Question: Which visualization type does this figure use?
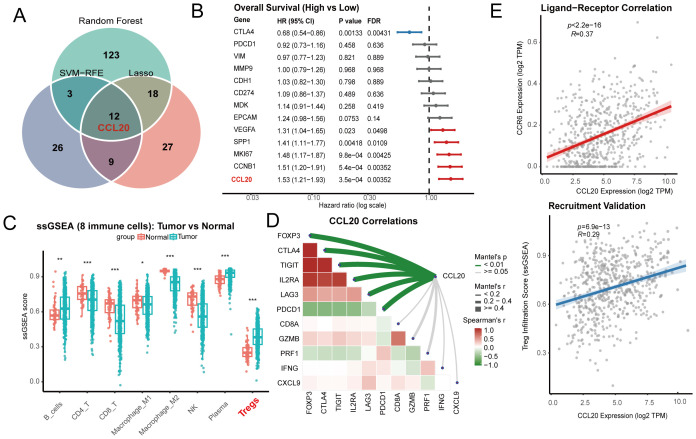
Answer: box